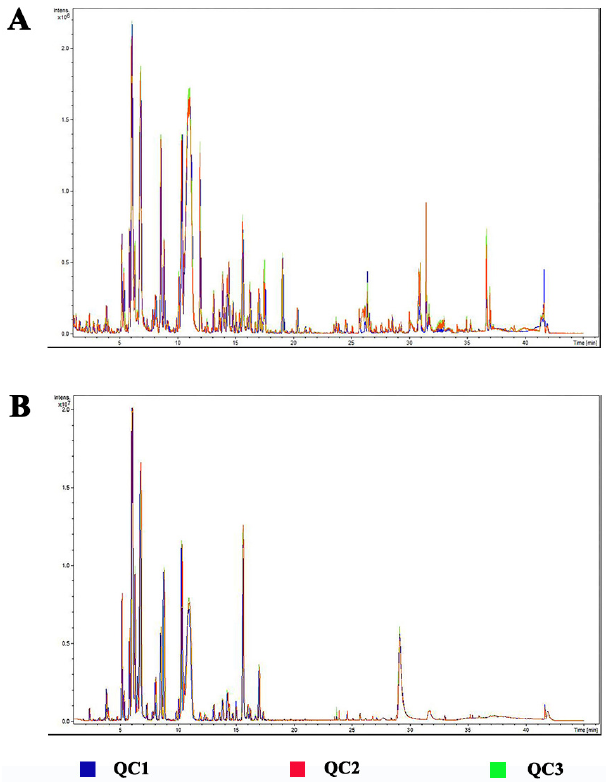
Figure 2. The total ion current chromatograms (TICs) of the QC samples. ( A ) positive ion mode (ESI+). ( B ) negative ion mode (ESI − ).